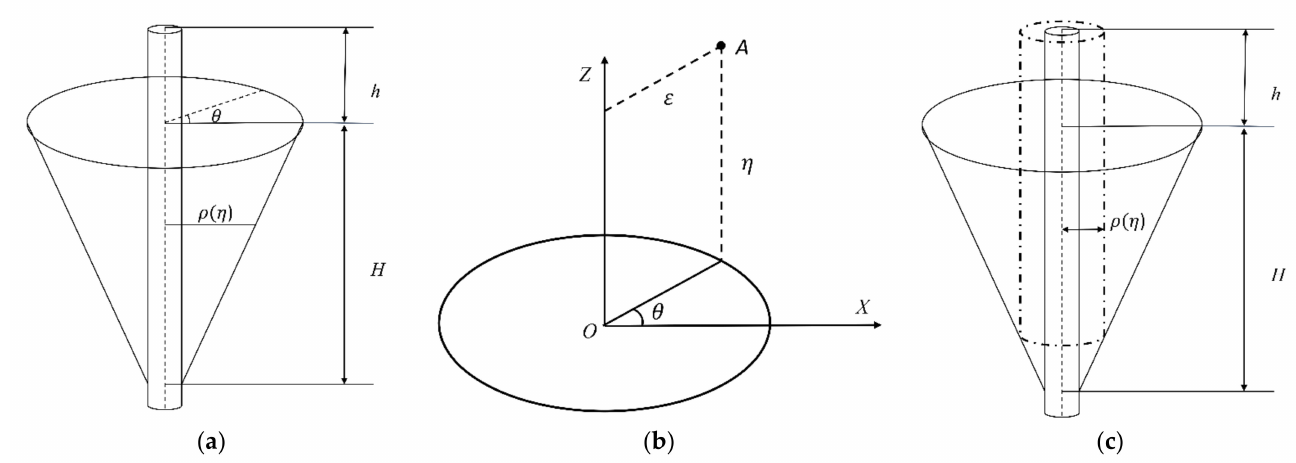
Figure 2. Schematic diagram of the PVD model: ( a ) drainage funnel around a single PVD; ( b ) coordinate system of the PVD model; and ( c ) model of a single